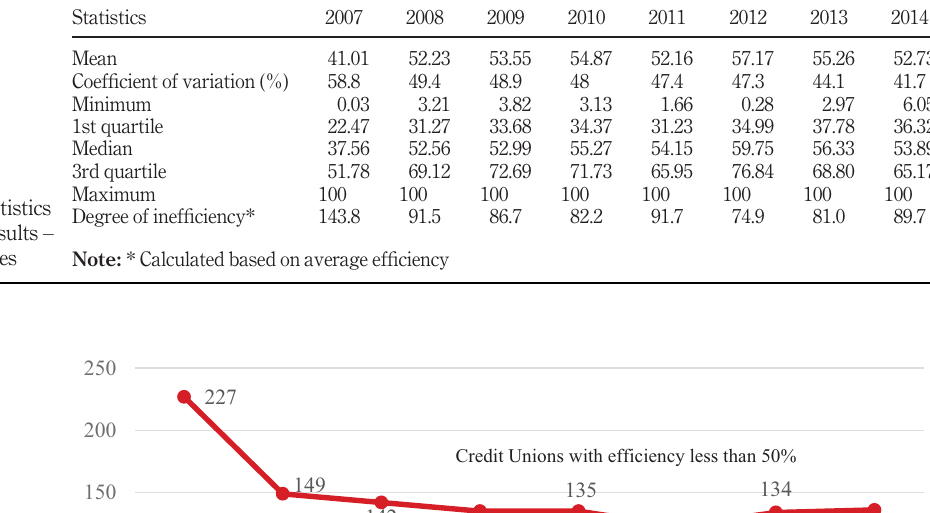
Figure 2. Evolution of the number of